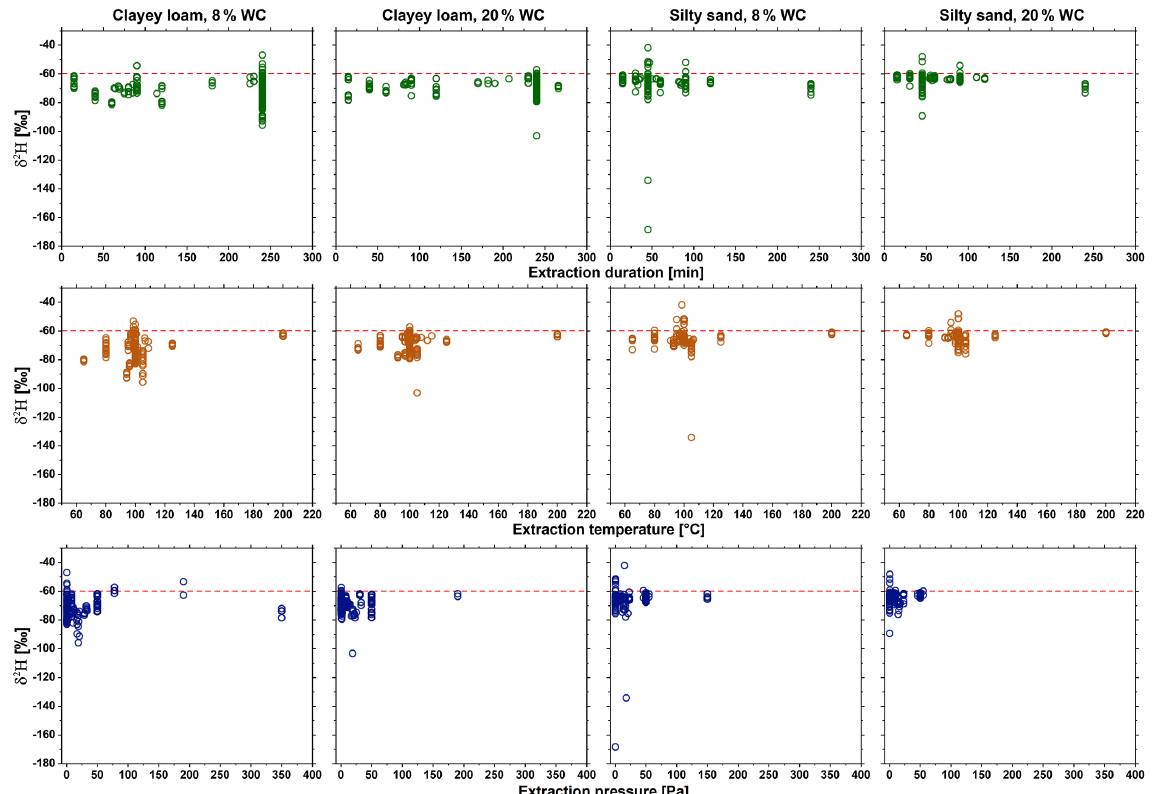
Figure 2. Effect of cryogenic extraction parameters (duration, temperature, and pressure) on δ 2 H results of both soil types (clayey loam and silty sand) and WCs (8 and 20%) shown for all labs. The mean reference DI water δ 2 H value is shown as a red dotted